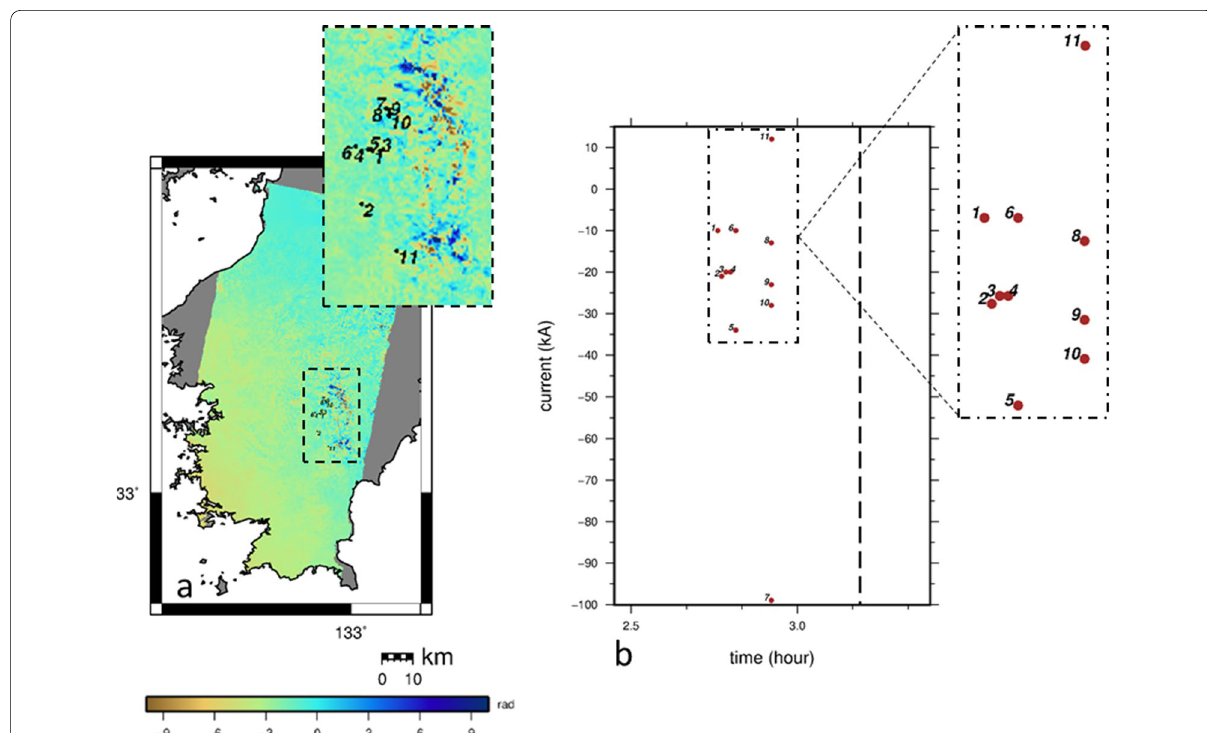
Fig. 6 �φ dispersive of SSM on Shikoku 20180815_20181107. a Overlaid by lightning location with an expanded view near the lightning. b Temporal relation of the lightning with the SAR imaging time indicated with the black dashed